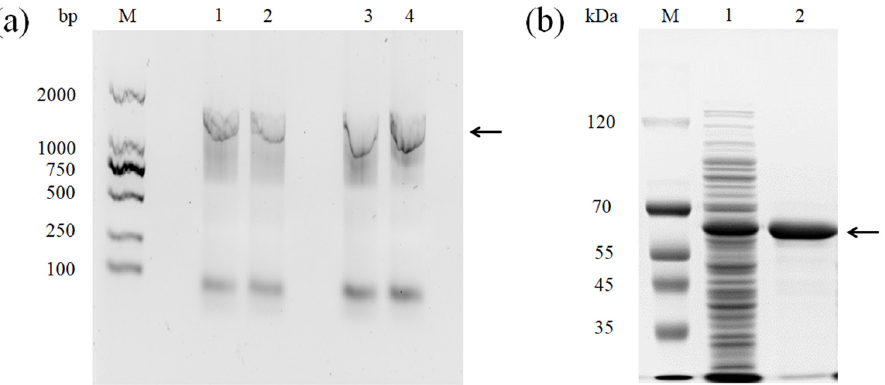
Figure 1. ( a ) Multicopper oxidase (MCO) gene amplification. Lane M, molecular weight markers